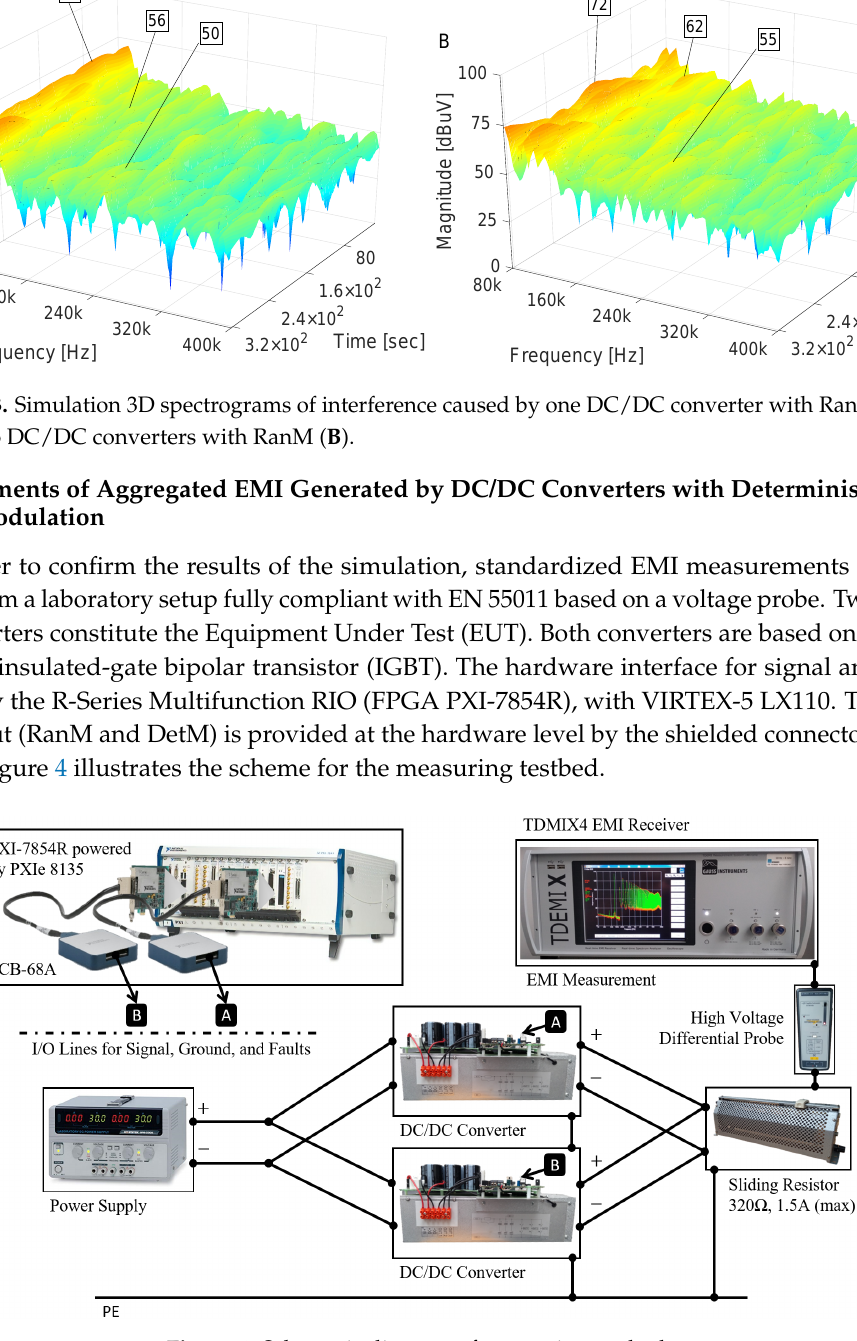
Figure 4. Schematic diagram of measuring